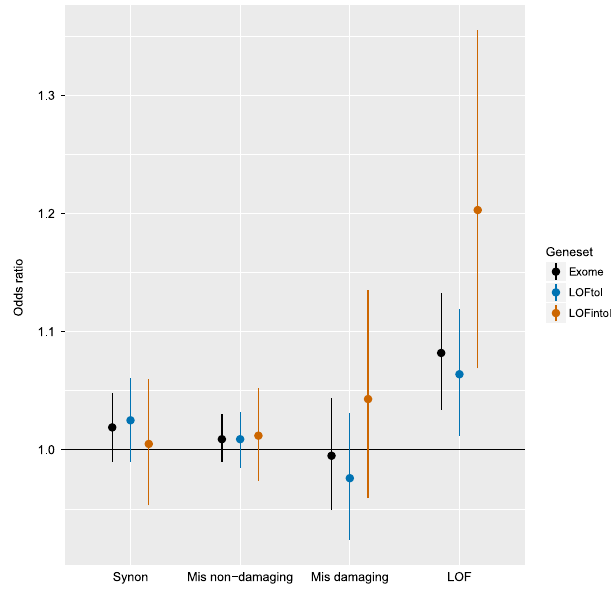
Fig. 2 Burden of coding ultra-rare SNVs and indels. X -axis: annotation class. Y -axis: odds ratio. Legend: exomes: coding variants in all genes; LOFtol: in genes tolerant to loss-of-function variation; LOFintol: in genes intolerant to loss-of-function variation. For each speci fi c burden test, we used a vertical line to indicate the 95% con fi dence interval of odds ratio and a dot at the center of the vertical line to indicate the point estimate of odds